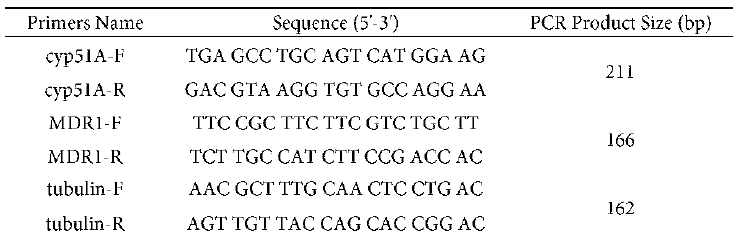
Table1. Sequences of primers